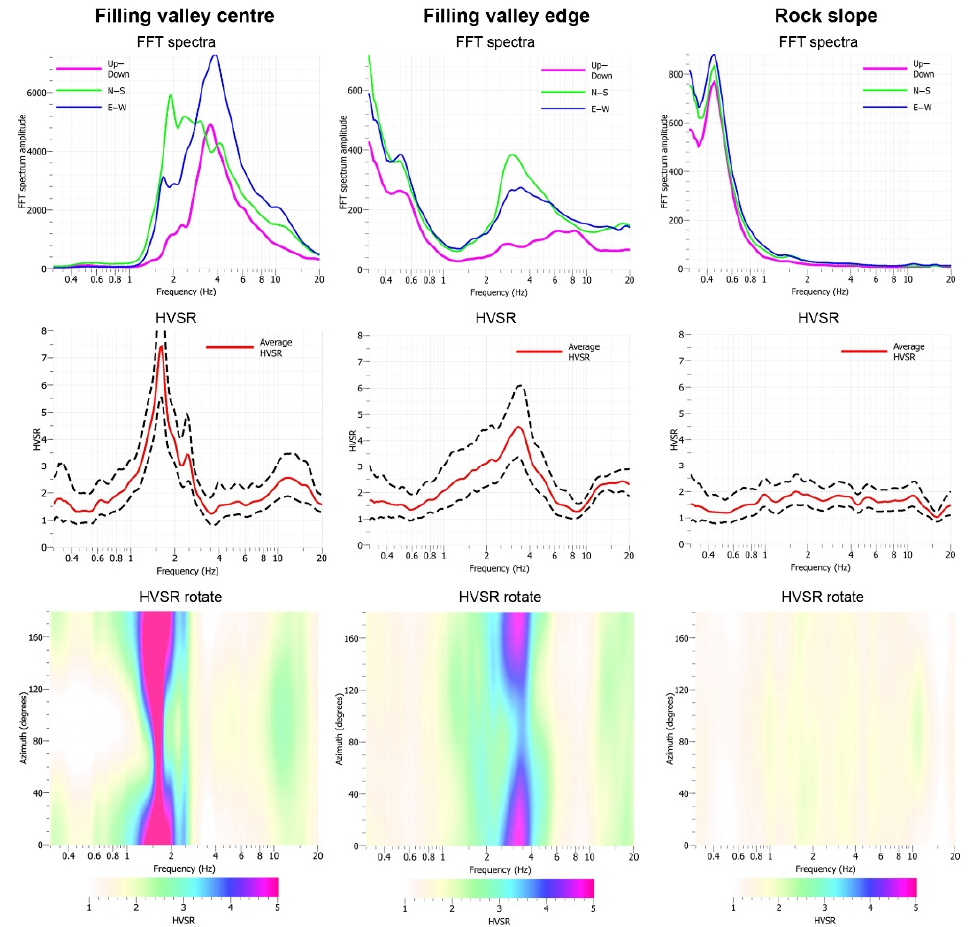
Figure 10. Examples of fast Fourier transform (FFT) spectra, horizontal-to-vertical spectral ratio (HVSR) function (the dashed black lines show the standard deviation of the curve), and HVSR rotate plot at the Poggio Cancelli valley obtained on fluviolacustrine deposits ( left panel ), alluvial fan ( middle panel ), and Laga Fm. flysch ( right panel ).